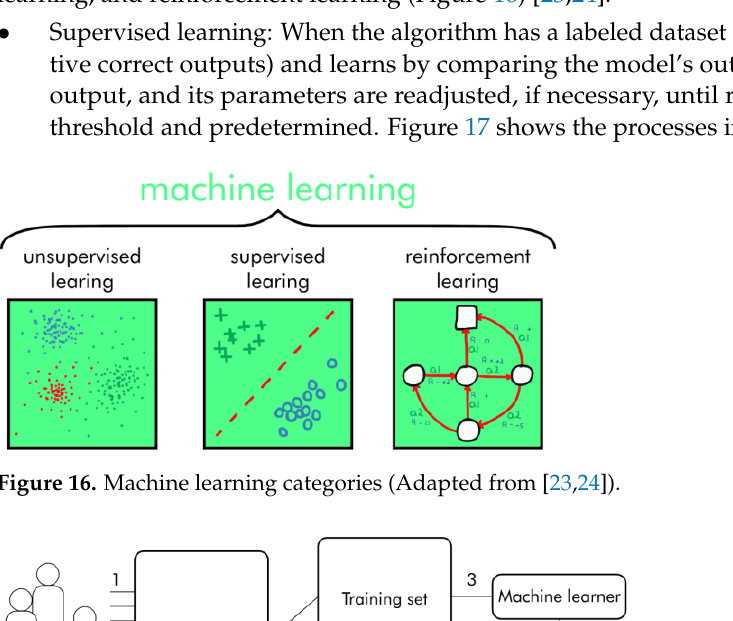
Figure 15. Subsets of artificial intelligence (Adapted from [23,24]).